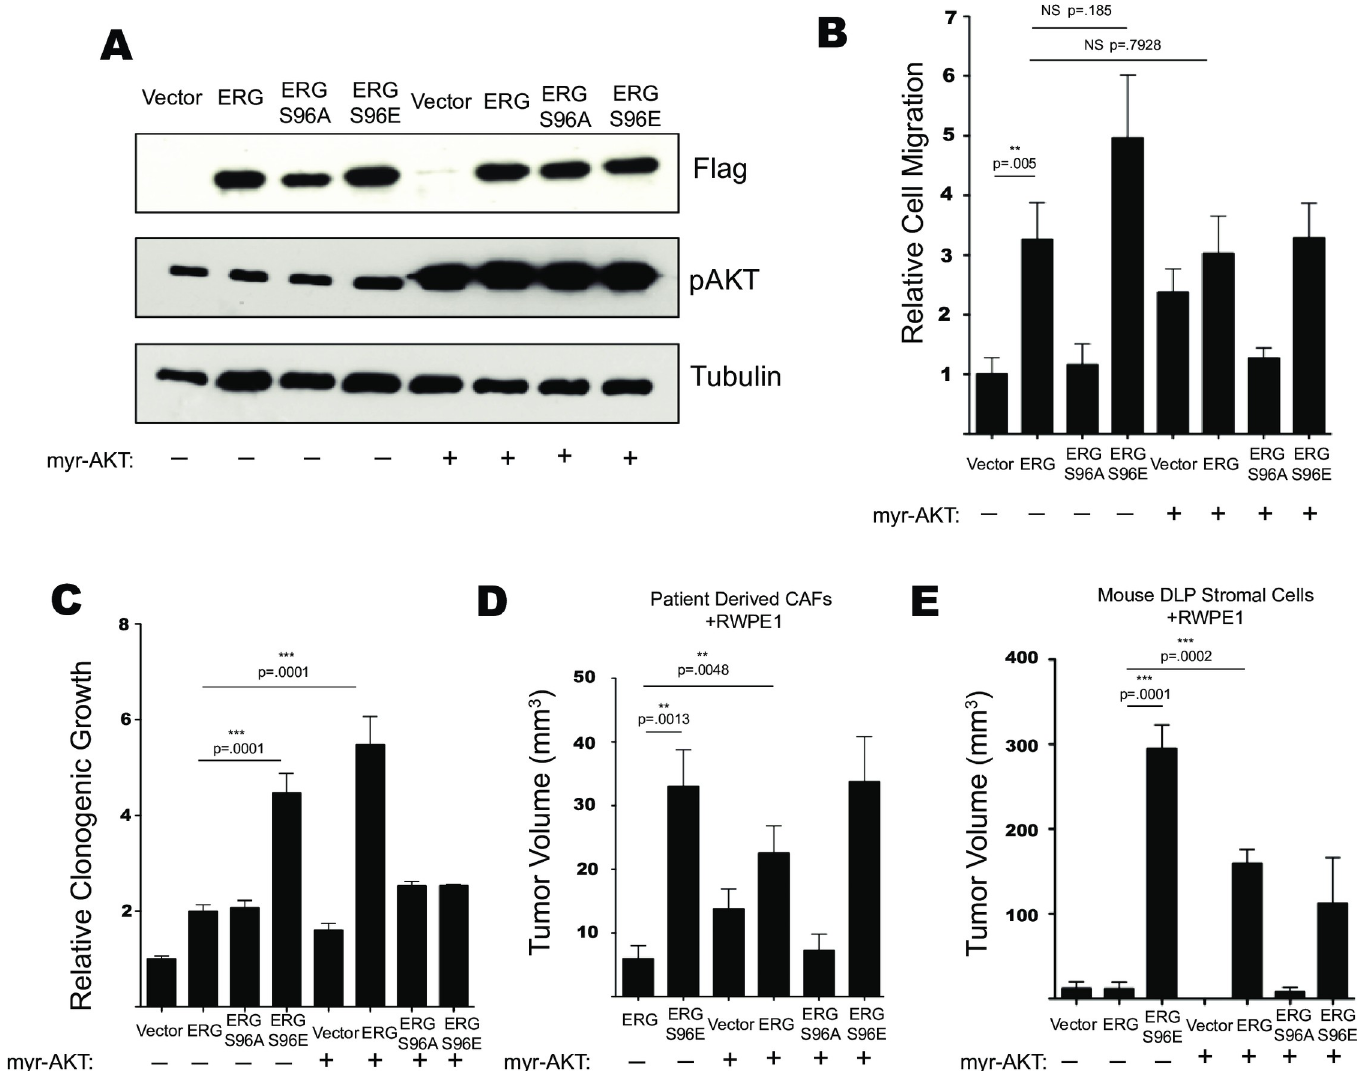
Fig 1. Ras/ERK and PI3K/AKT signaling differentially regulate ERG mediated phenotypes. (A) Immunoblot of RWPE1 cells expressing FLAG-tagged ERG or mutant, and myristoylated AKT as indicated. (B) Transwell cell migration of RWPE1 cells expressing indicated constructs. Shown are the mean and SEM normalized to vector of 4 biological replicates, each the mean of 2 technical replicates. (C) Clonogenic growth of RWPE1 cells sparsely plated and allowed to form colonies over 10 days followed by fixing, staining, and quantification via Sygene GeneTools colony counting software. (D) Mouse xenograft experiments measured by calipers of RWPE1 cell lines grown (n = 6) in the flanks of immunocompromised mice for 8 weeks with patient derived CAFs or (E) RWPE1 cells grown (n = 4 or 6) with DLP-derived stromal cells from INK4A null